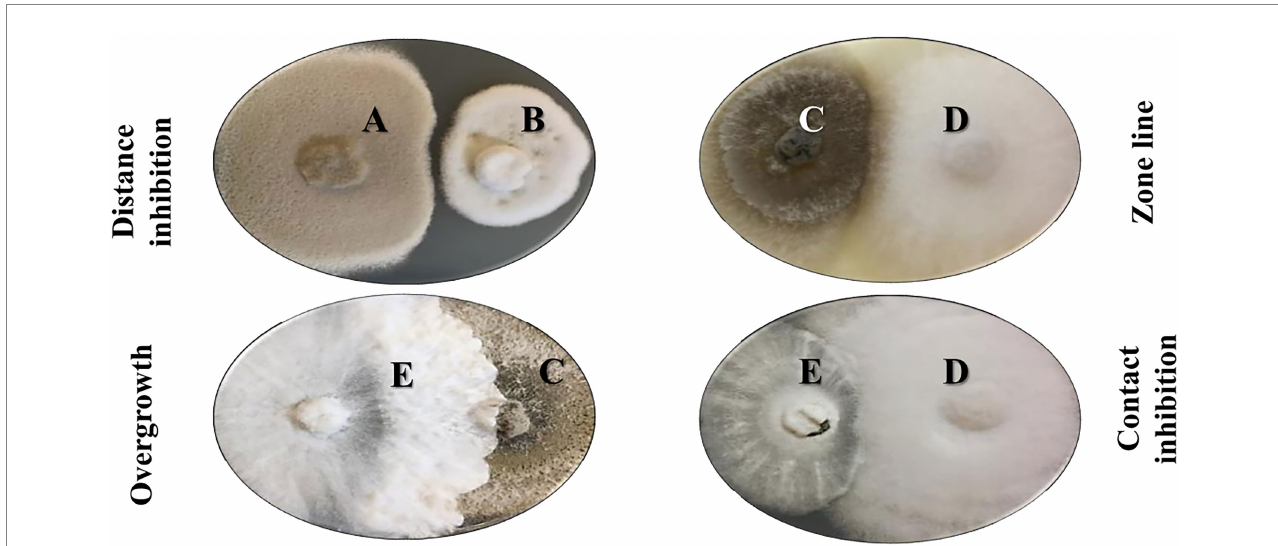
FIGURE 4 Morphological interactions in co-culture experiments with five different fungi on solid media. A: Alternaria alternata , B: Colletotrichum acutatum , C: Diaporthe eres , D: Fusarium oxysporum , E: Xylaria cubensis . Bertrand and colleagues reported four major morphological outcomes in these co-culture experiments in solid media: distance inhibition, zone lines, contact inhibition, and overgrowth (Bertrand et al.,